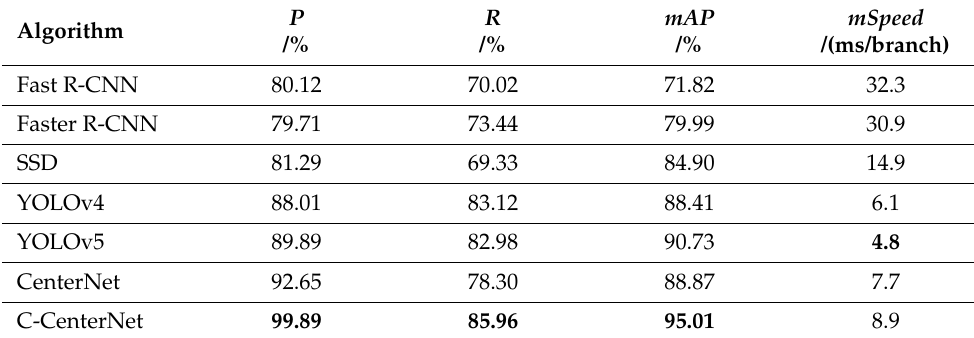
Table 2. Comparison of the results of various algorithms.